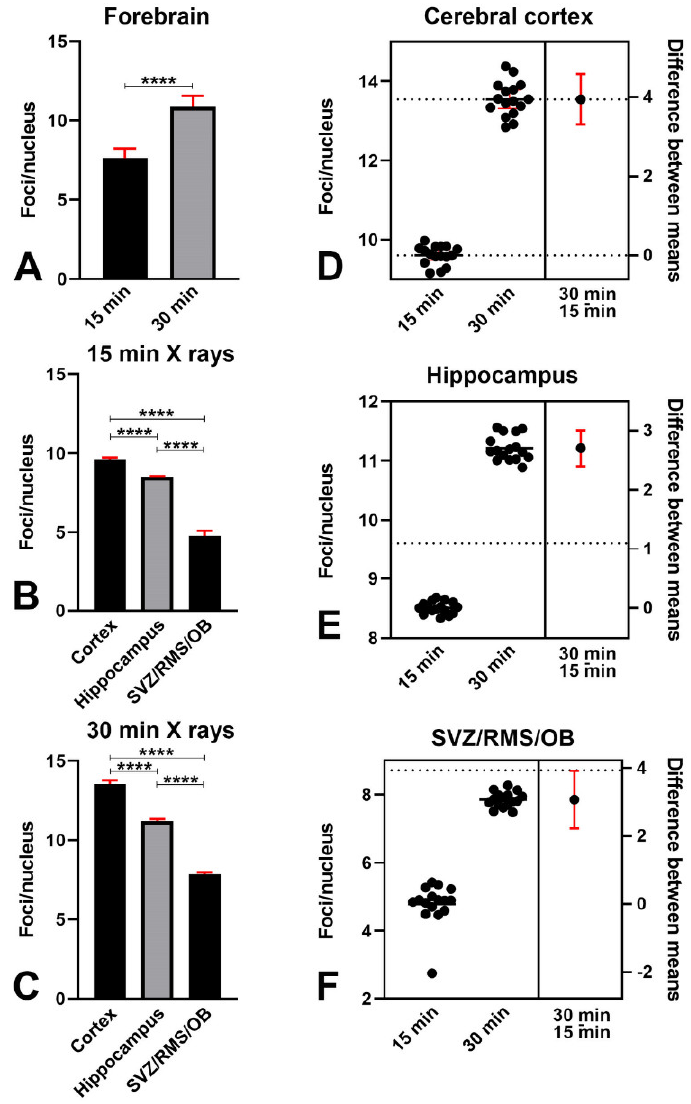
Figure 5. Number of γ H2AX immunoreactive foci per nucleus in short- and long-term survivors after X-ray irradiation. ( A ): Difference in the mean number of immunoreactive foci/nuclei in the forebrain at 15- and 30 min survival (15 min: 7.633 ± 0.616; 30 min: 10.87 ± 0.69; Mann–Whitney test, two-tailed exact p value < 0.0001). ( B ) Difference in the mean number of foci/nuclei among forebrain areas in short survival (15 min) group. Ordinary one-way ANOVA followed by Tukey’s multiple comparisons test (cerebral cortex: 9.609 ± 0.129; hippocampus: 8.510 ± 0.054; OB/SVZ/RMS 4.779 ± 0.3275–adjusted p values for all comparisons < 0.0001). ( C ) Difference in the mean number of foci/nuclei among forebrain areas in long-term survival (30 min) group. Ordinary one-way ANOVA followed by Tukey’s multiple comparisons test (cerebral cortex: 13.55 ± 0.23; hippocampus 11.21 ± 0.12; OB/SVZ/RMS 7.852 ± 0.12; adjusted p values for all comparisons < 0.0001). ( D ) Differences in the mean number of foci/nuclei in the cerebral cortex after short- and long-term survival. Unpaired t-test with Welch’s correlation; two-tailed p value < 0.0001. ( E ) Differences in the mean number of foci/nuclei in the hippocampus after short- and long-term survival. Unpaired t-test with Welch’s correlation–two-tailed p value < 0.0001. ( F ) Differences in the mean number of foci/nuclei in the SVZ/RMS/OB after short and long survival. Unpaired t-test with Welch’s correlation; two-tailed p value < 0.0001. **** p < 0.0001. Bars are 95% CI. Staining was carried out with the Calbiochem primary antibody against γ